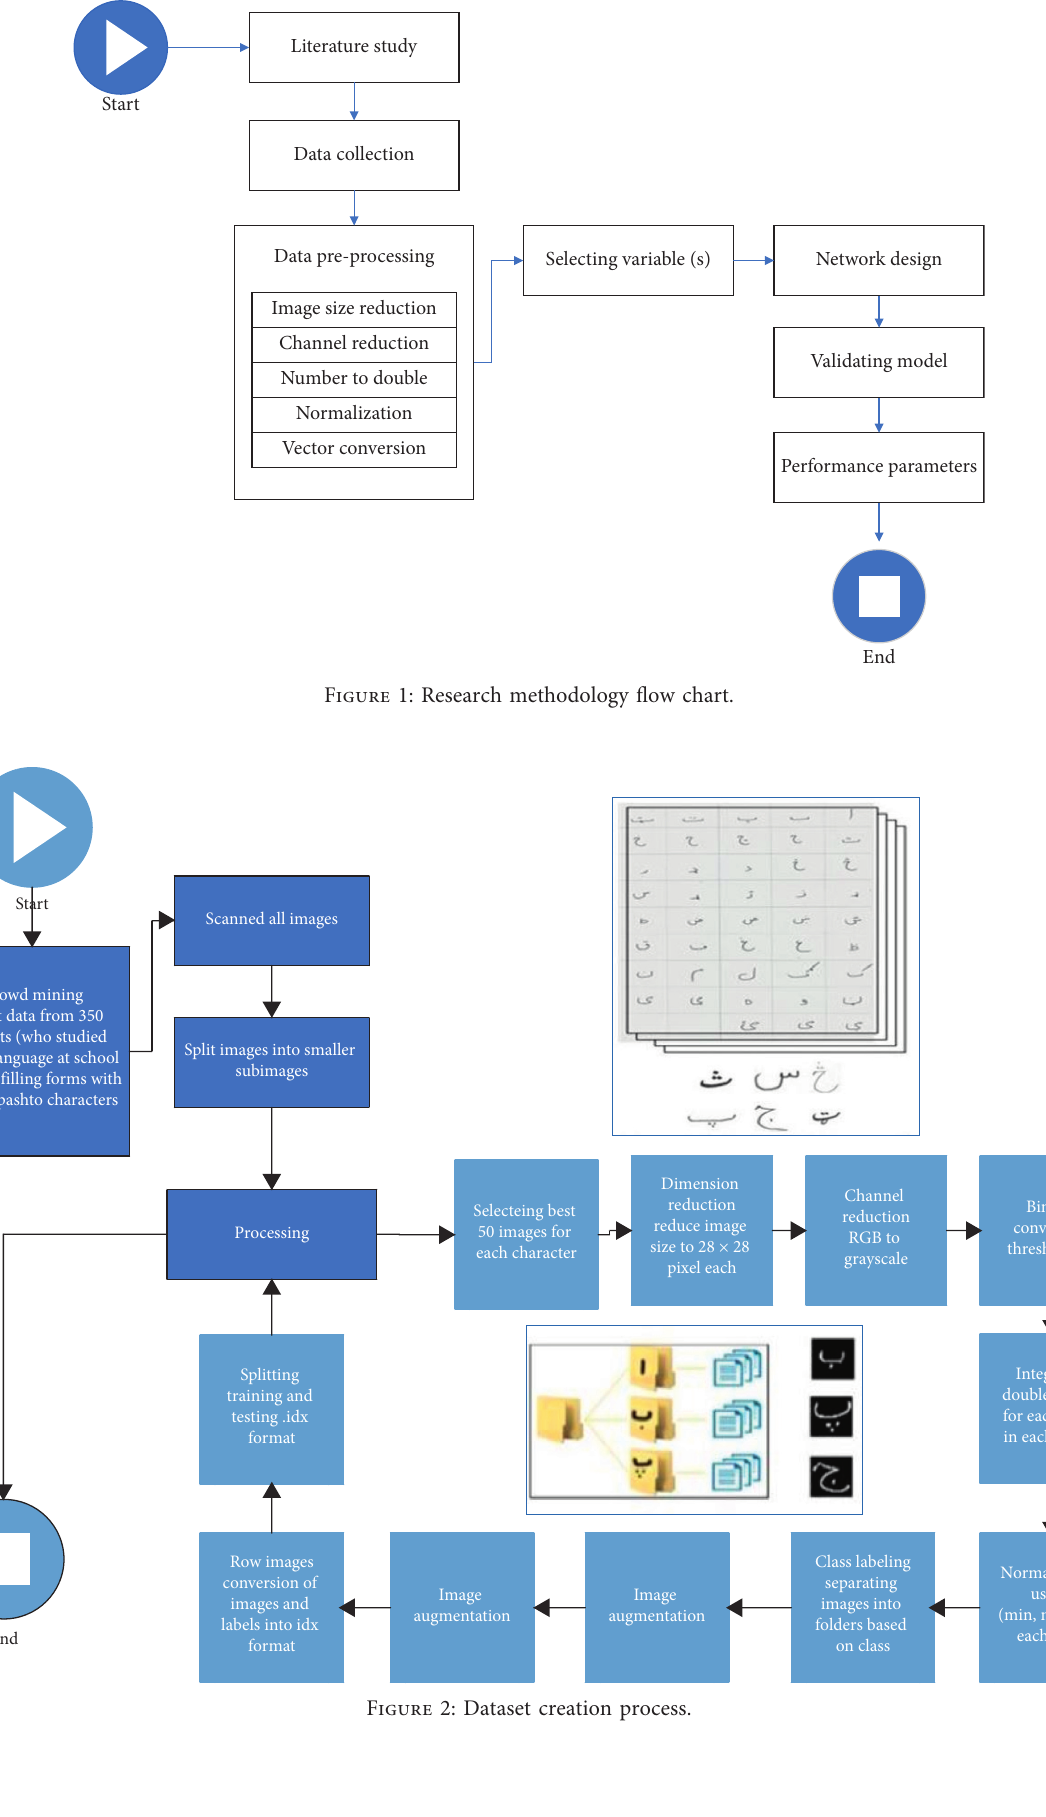
Figure 2: Dataset creation process.